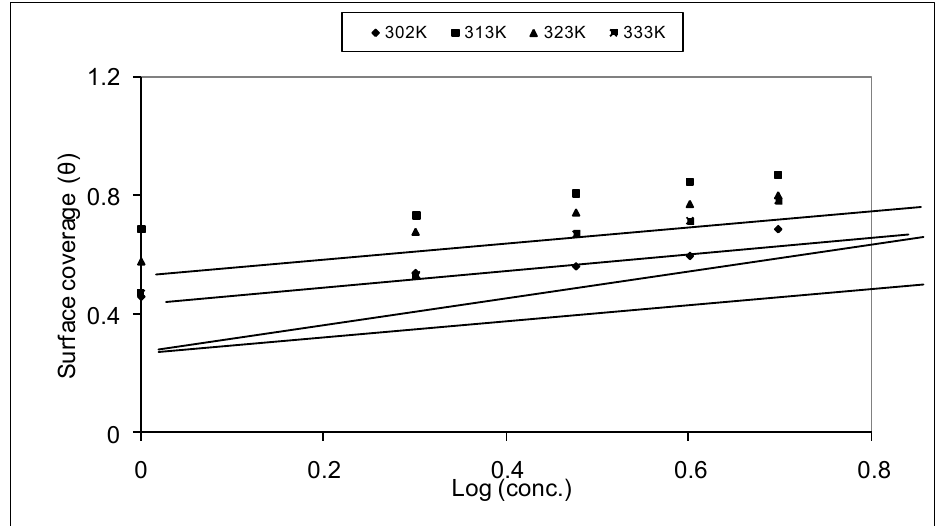
Figure 3 .Tempkin’s adsorption isotherm for corrosion behaviour of mild steel in 2N Sulphuric acid with